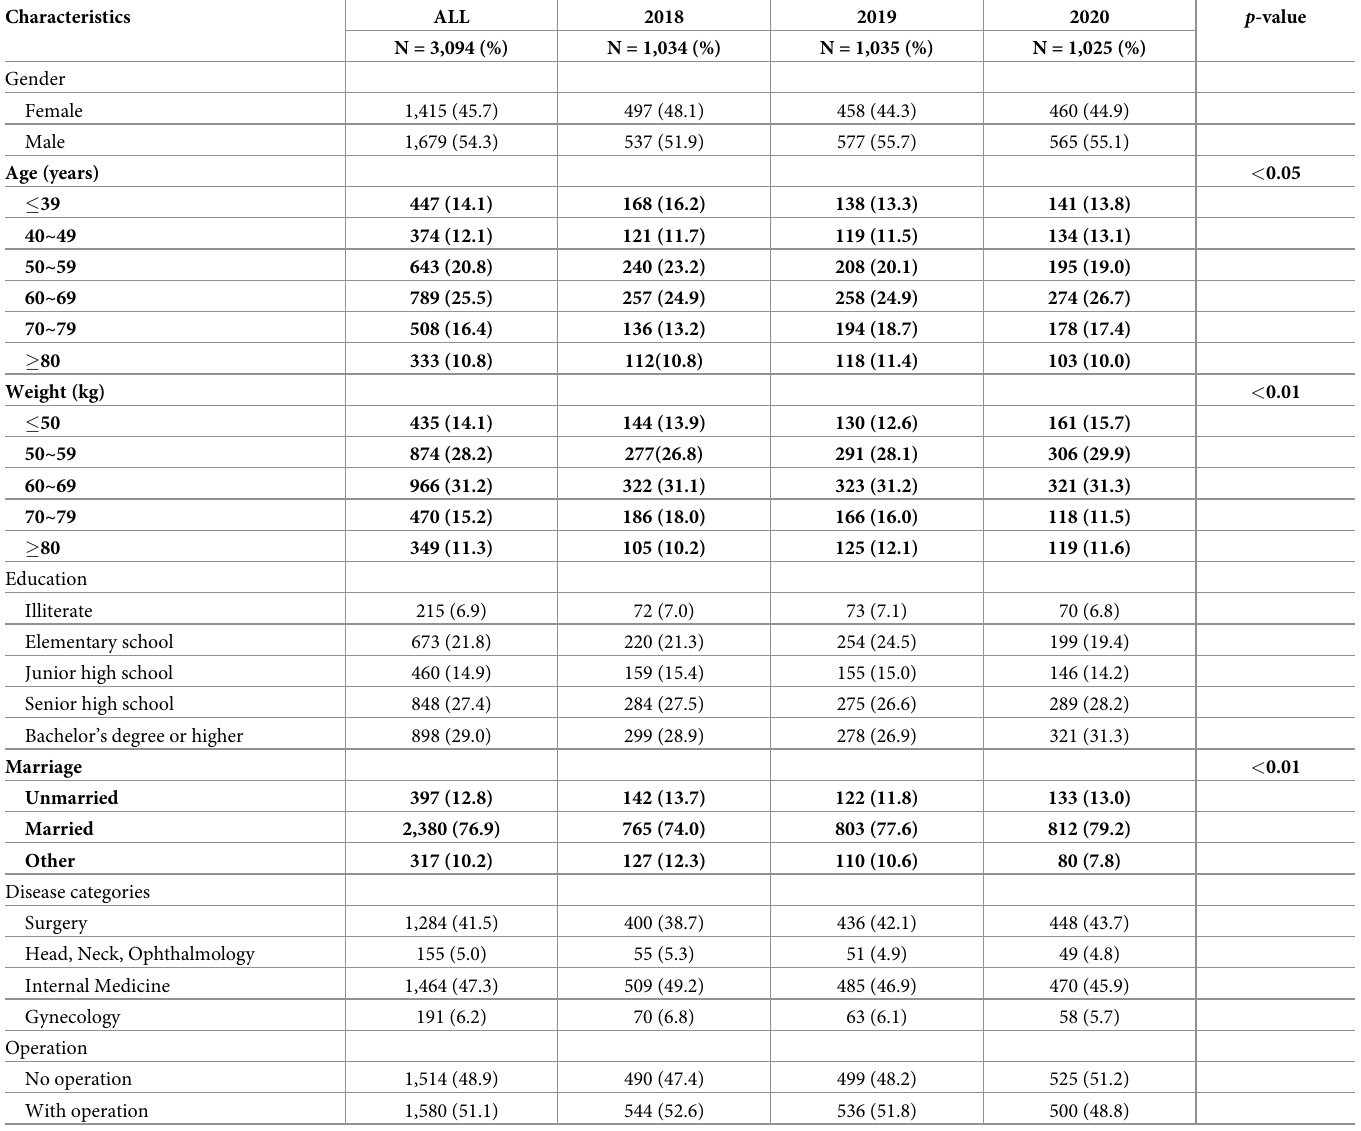
Table 1. Demographic data of the patients from 2018 to